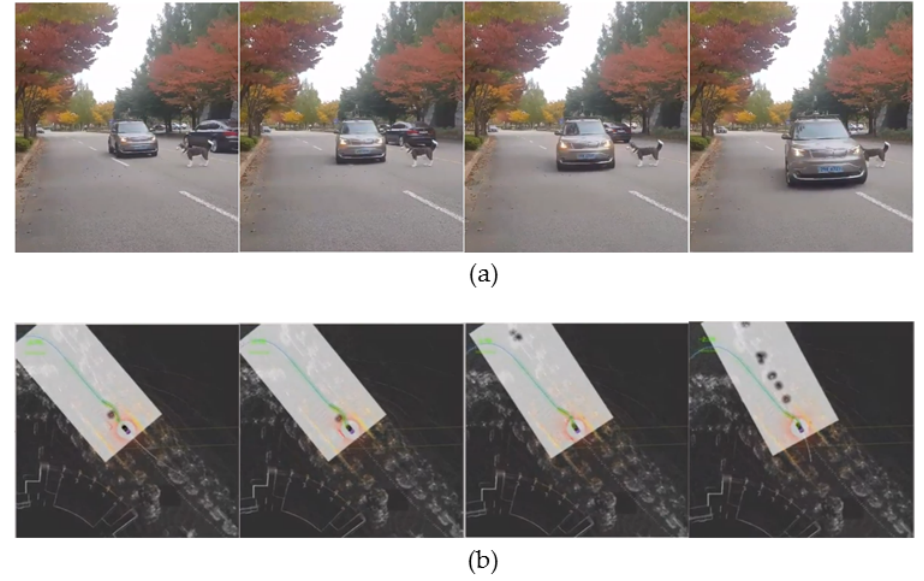
Figure 12. ( a ) The frames in which the obstacle avoidance is done. An obstacle (a mannequin husky) is placed in front of the autonomous vehicle. ( b ) The visualization of pure pursuit and the changed waypoints path (Best viewed in